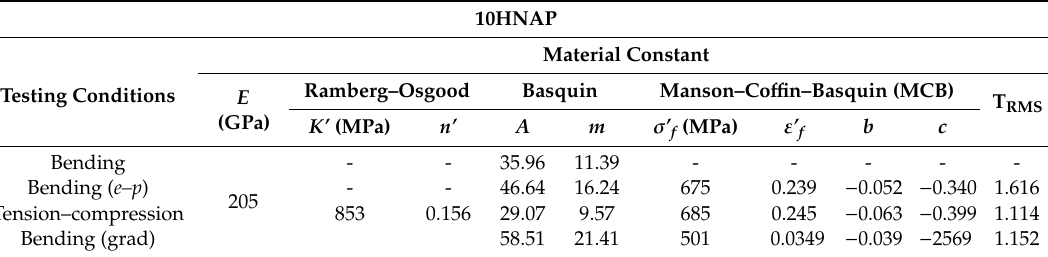
Table 3. The cyclic properties of 10HNAP steel.